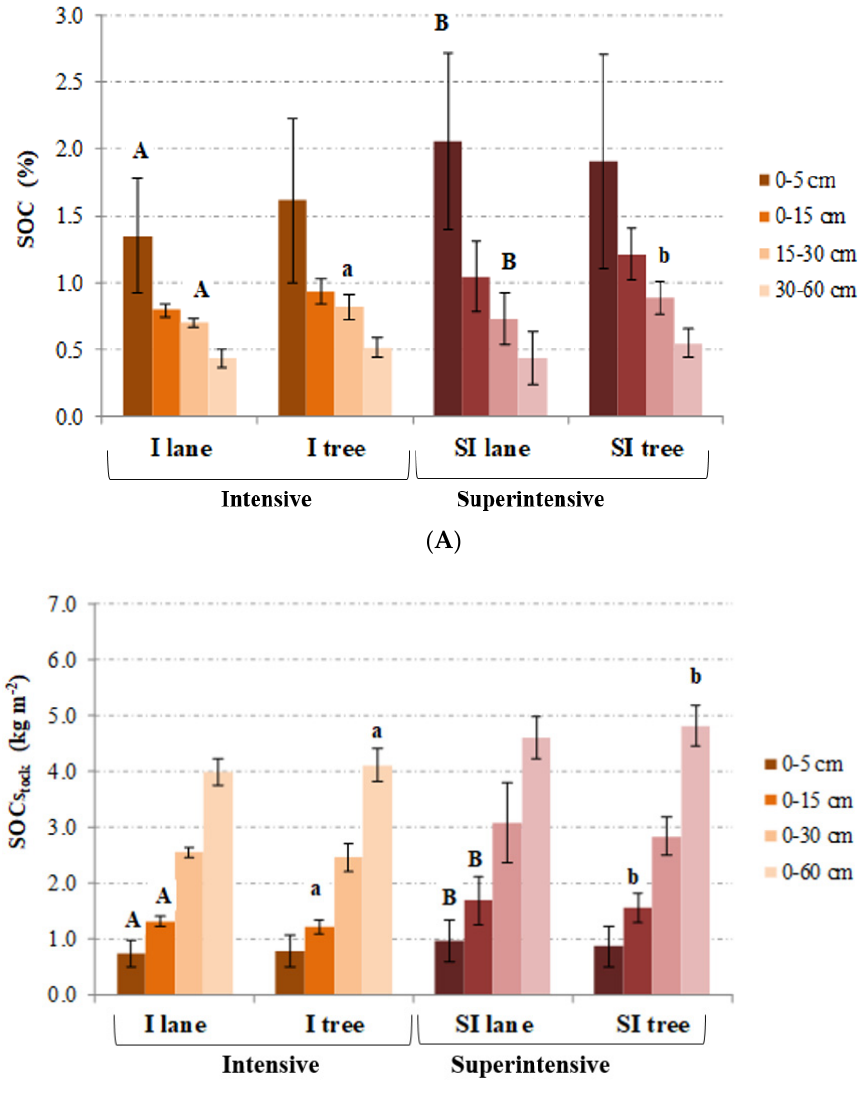
Figure 2. ( A ) Soil organic carbon concentration (SOC; %), and ( B ) cumulative soil organic carbon stock (SOC stock ; kg m − 2 ) by soil depth and location (lane or tree) within the two olive orchards (I: intensive; SI: superintensive) for the soil sampling carried out in 2013. Different letters indicate statistically significant differences ( p < 0.05, using a Kruskal–Wallis test) between the two orchards for the same depth and location (lane, capital letters, or tree, lowercase letters). Error bars are standard deviation, n = 8.